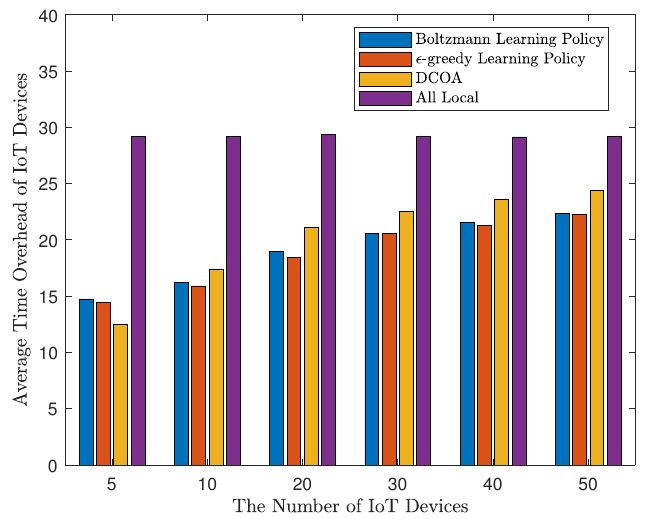
Figure 2. Average time overhead of the Internet of Things (IoT) devices.